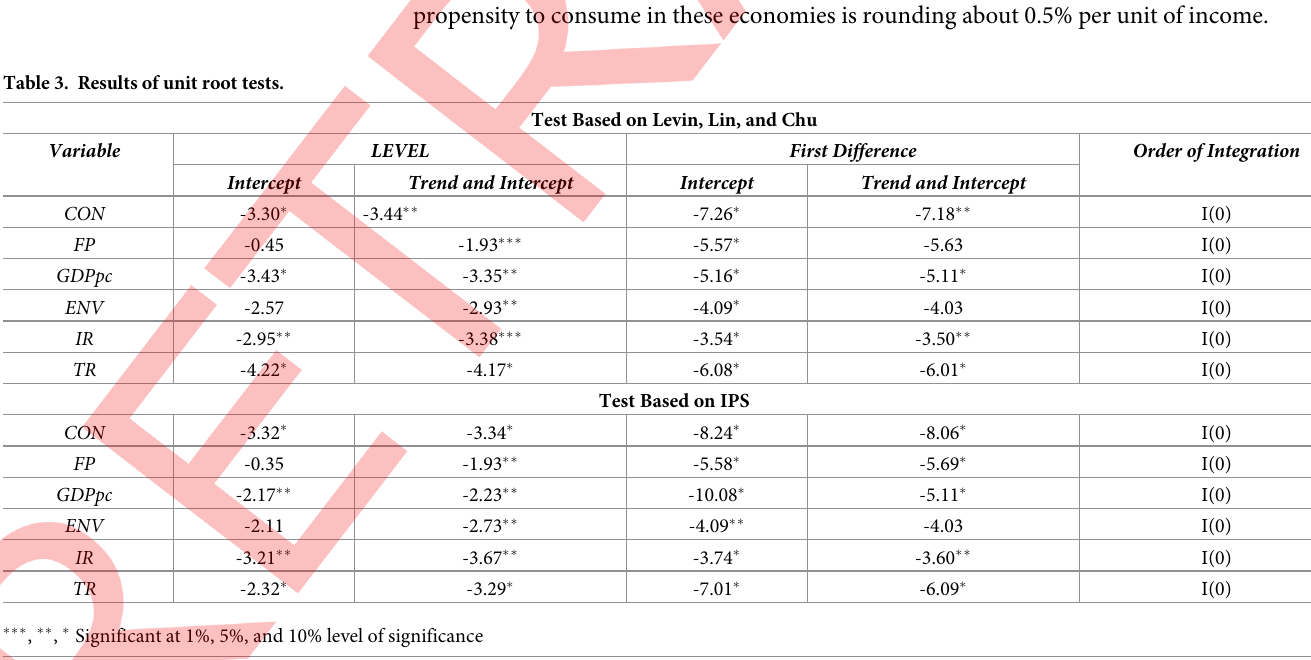
Table 3. Results of unit root